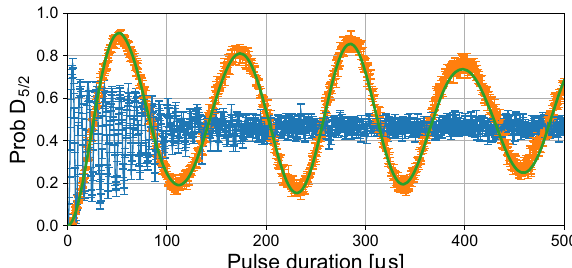
Fig. 5 Blue sideband Rabi oscillations after transport for the optimized decimated (blue) and non-decimated (orange) trajectory-plus-axial optimizations. The green curve is a maximum likelihood estimation for a displaced thermal state illustrating sub- quanta excitation. For the decimated version the ion is in a highly excited state after transport and did not achieve sub-quanta transport. Error bars represent the standard distal location with the optimized waveform (Fig. 4). Prior to (cid:1) (cid:3) (cid:1) shuttling a π /2 pulse is applied to the ion on the S 1 = 2 ; (cid:2) 1 $ 2 D 5 = 2 ; (cid:2) 3 2